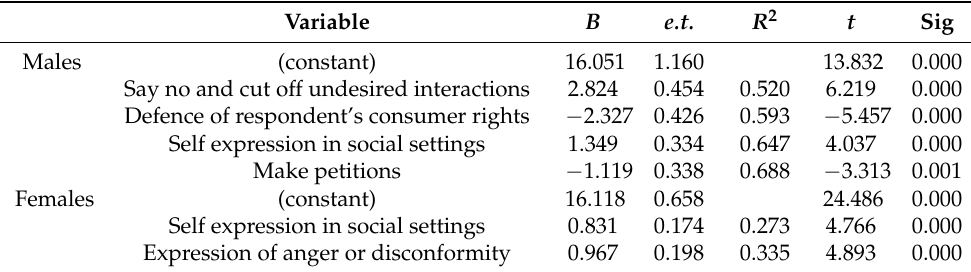
Table 3. Social skills as predicting factors of happiness according to